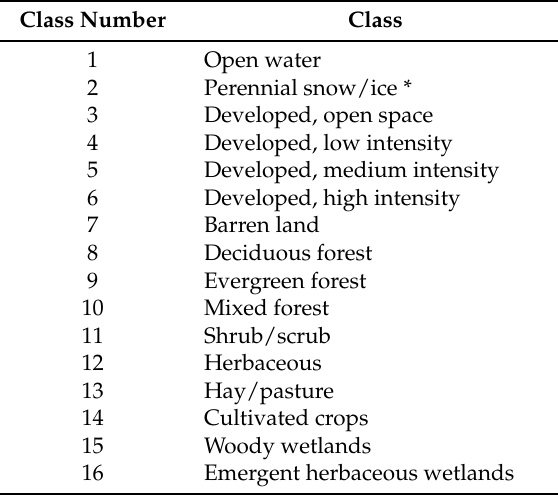
Table 1. Land cover classes according to National Land Cover Dataset (NLCD) 2011.